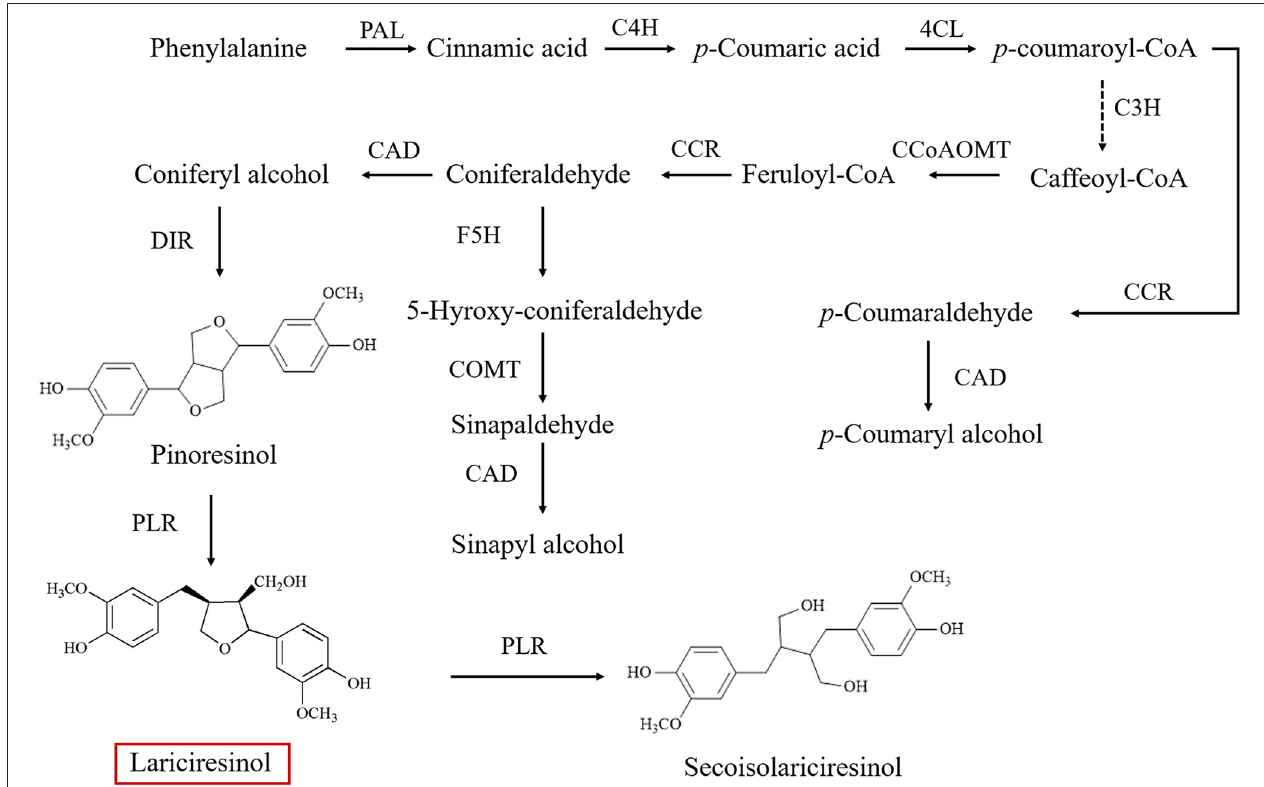
FIGURE 1 | Biosynthetic pathway of lignins in Isatis indigotica (PAL, phenylalanine ammonia-lyase; C4H, cinnamic acid 4-hydroxylase; 4CL, 4-coumarate coenzyme A ligase; C3H, coumarate 3-hydroxylase; CCoAOMT, caffeoyl CoA O-methyltransferase; CCR, cinnamoyl-CoA reductase; F5H, ferulate 5-hydroxylase; COMT 1, caffeic acid O -methyltransferase; CAD, cinnamyl alcohol dehydrogenase; DIR, dirigent protein; PLR, pinoresinol reductase).